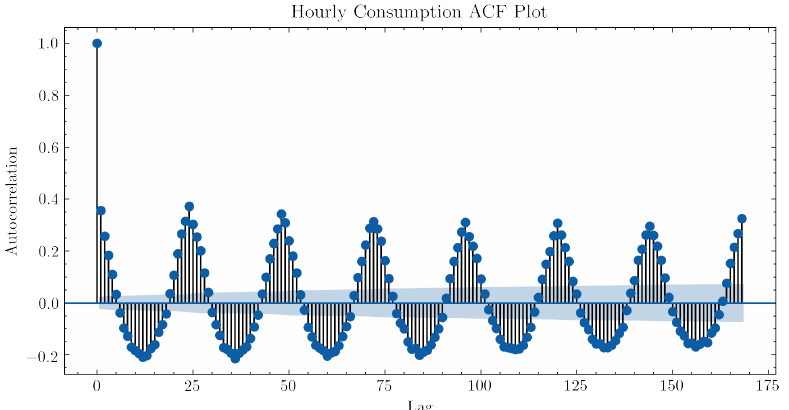
Figure 6. Autocorrelation function of the hourly energy consumption (95% significance band).